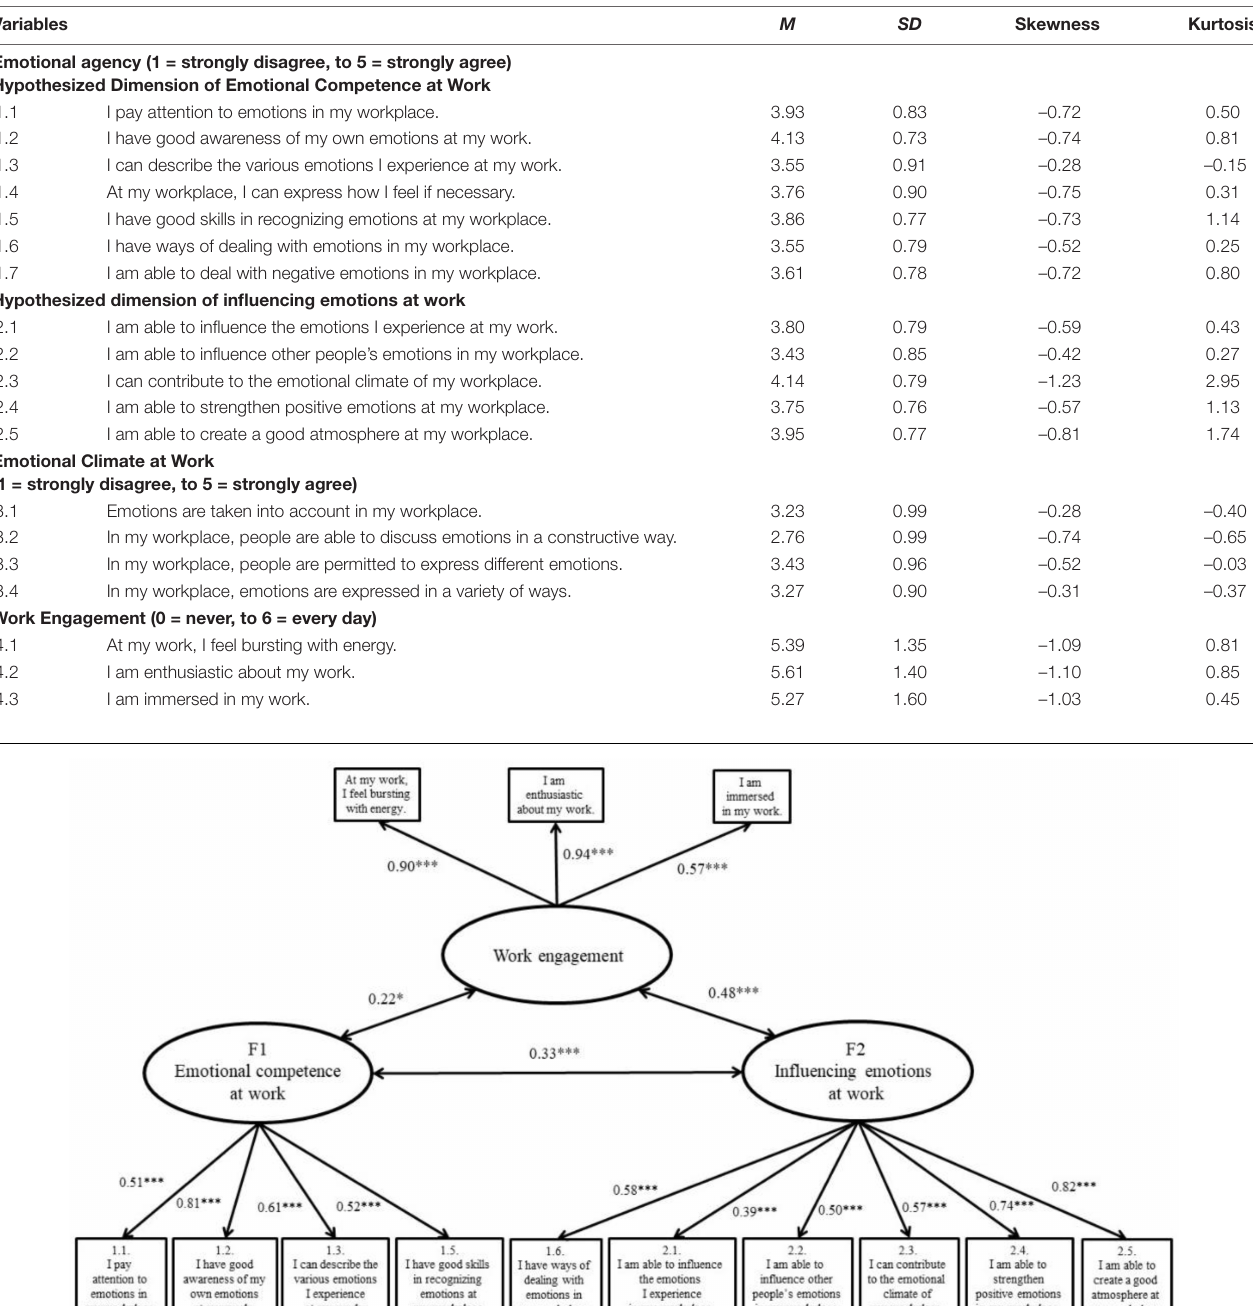
TABLE 2 | Descriptive statistics for the studied variables ( N = 240). Variables M SD Skewness Kurtosis